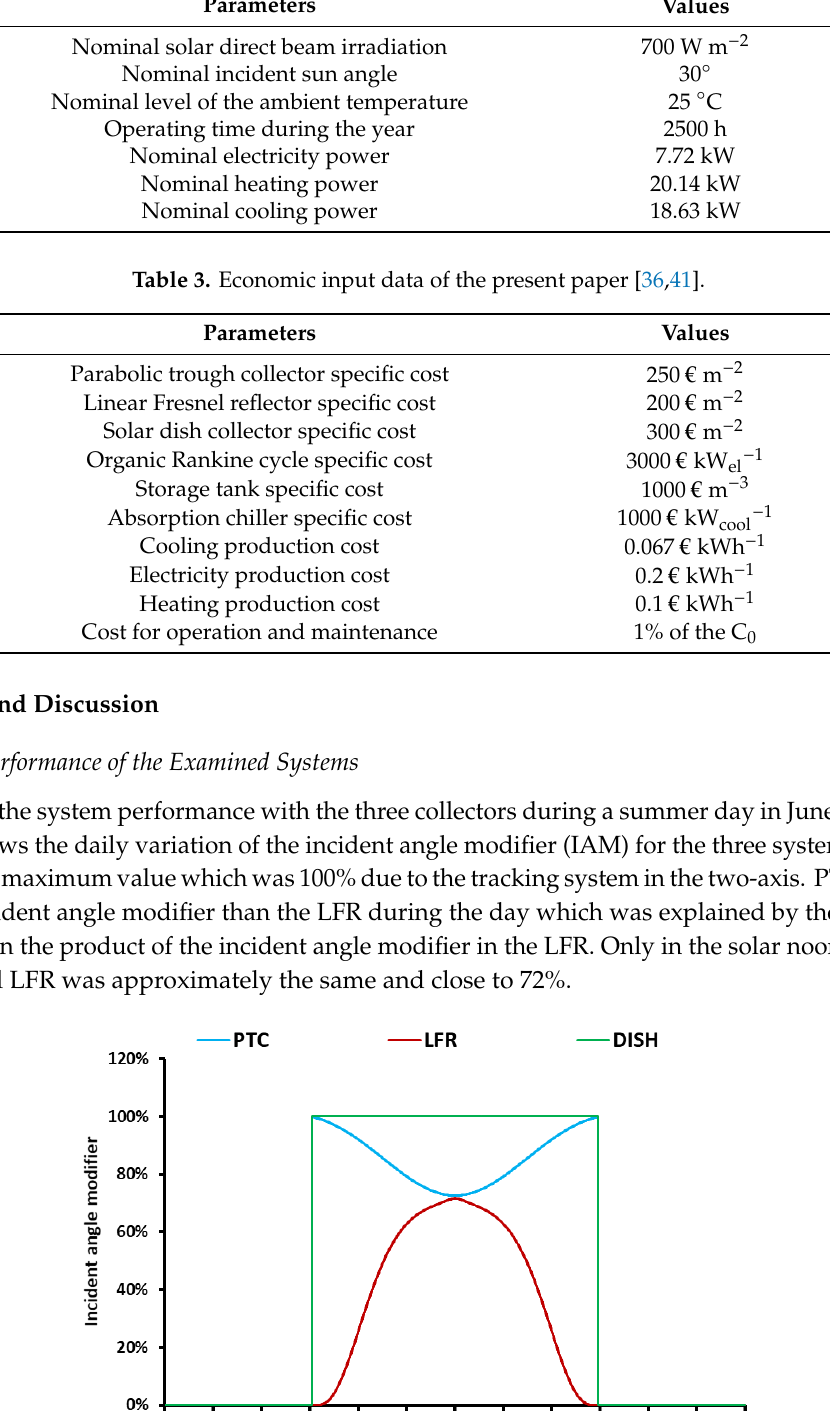
Table 2. Data of the system in the nominal design point.